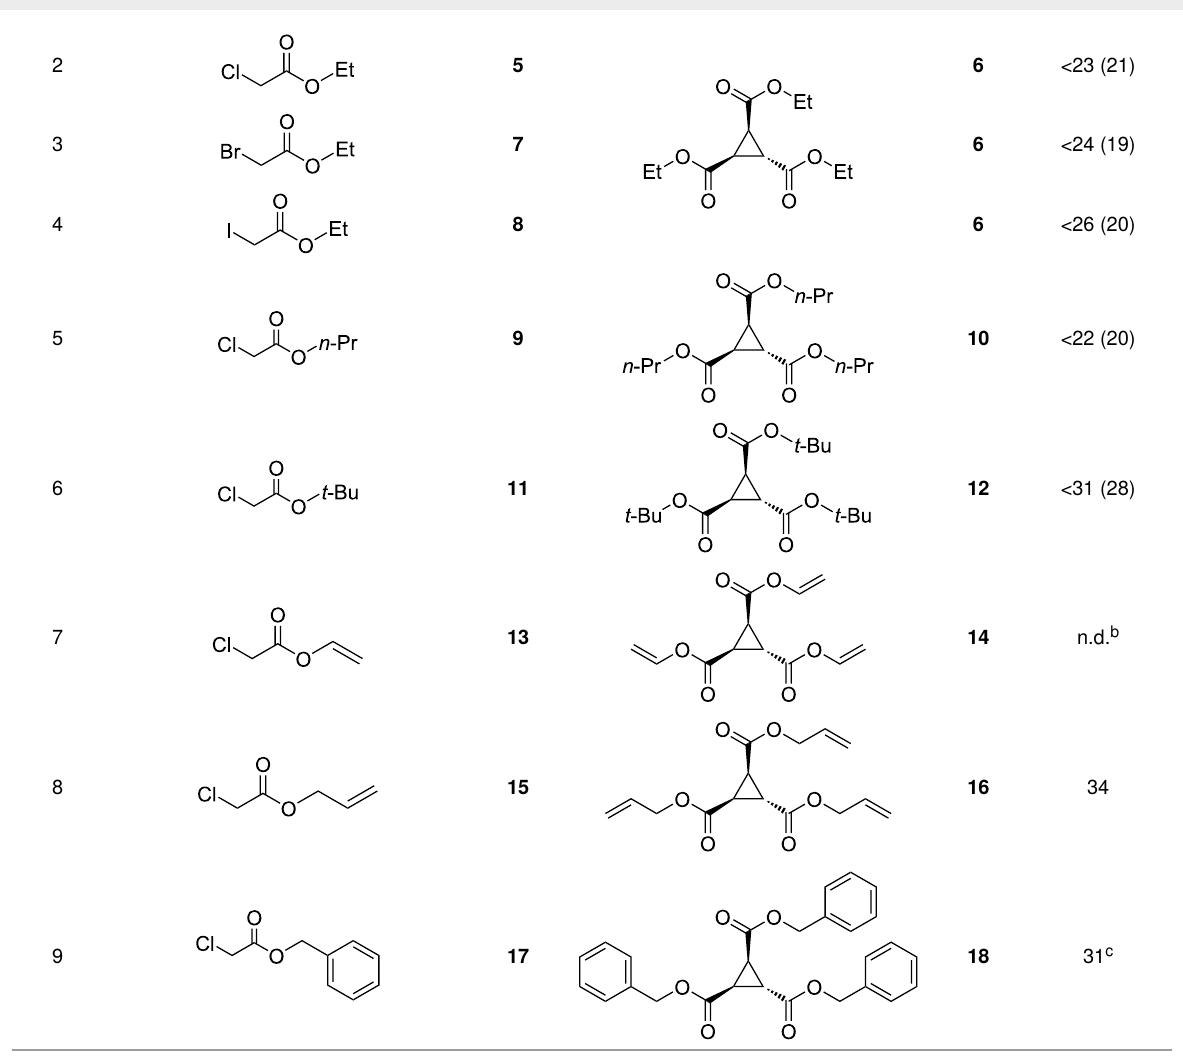
Table 3: Scope and limitations.